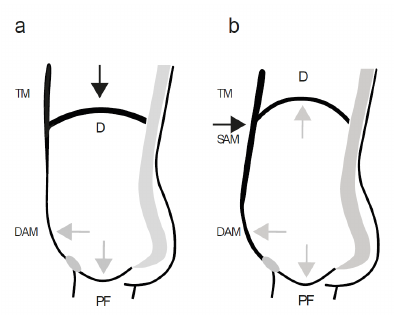
Figure 3. A schematic representation of a mid-sagittal view through the abdominal cavity to demon- strate the movements and contractile state of the muscle groups surrounding the abdominal cavity during ( a ) inspiration and ( b ) physical strain with an inspiratory motor synergy against a closed glottis. D = thoracic diaphragm, PF = pelvic floor, DAM = deep anterolateral abdominal muscles, SAM = superficial anterolateral abdominal muscles, TM = thoracic muscles. The thicker lines indicate muscle contraction and the thinner lines indicate muscle relaxation. The black arrows indicate an active force vector and the grey arrows indicate a passive force transmission.